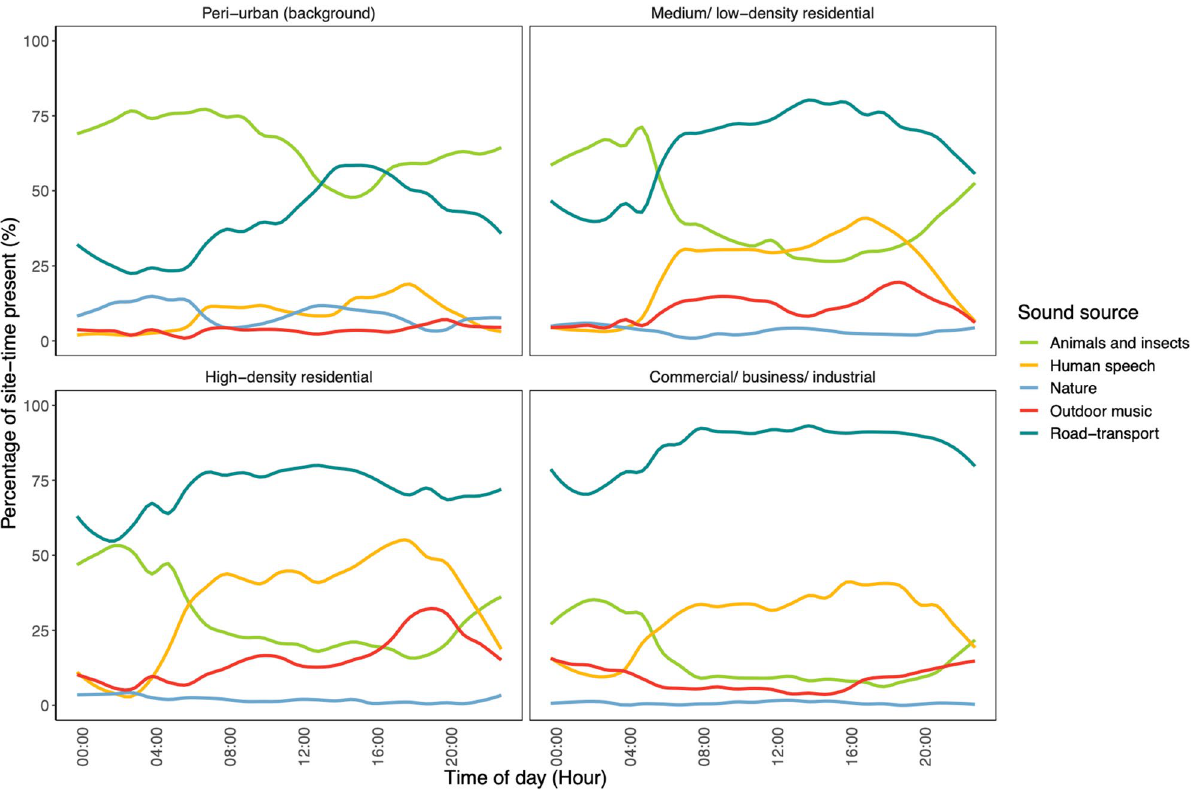
Figure 4. Diurnal patterns of the percentage of site-time that detected road-transport, animal and insect, human speech, outdoor music and nature sound sources were present for each hour of the day and within land use areas in the Greater Accra Metropolitan Area. Data are from rotating sites, but fixed sites had similar